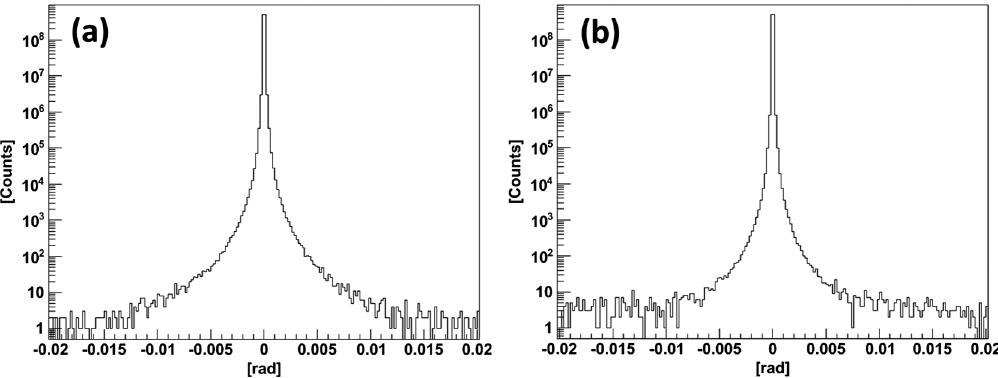
FIG. 3. The proton scattering distribution by the charge-exchange foil at (a) 181 MeV with 200 (cid:1) g = cm 2 foil thickness, and (b) 400 MeV with 300 (cid:1) g = cm 2 foil thickness.